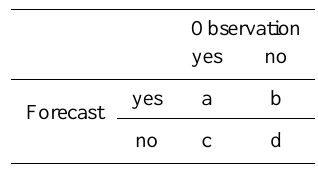
Table 3. 2 × 2 contingency table: pairs of measured and simulated values are classified as hits (a), false alarms (b), misses (c) and cor- rect negatives (d).